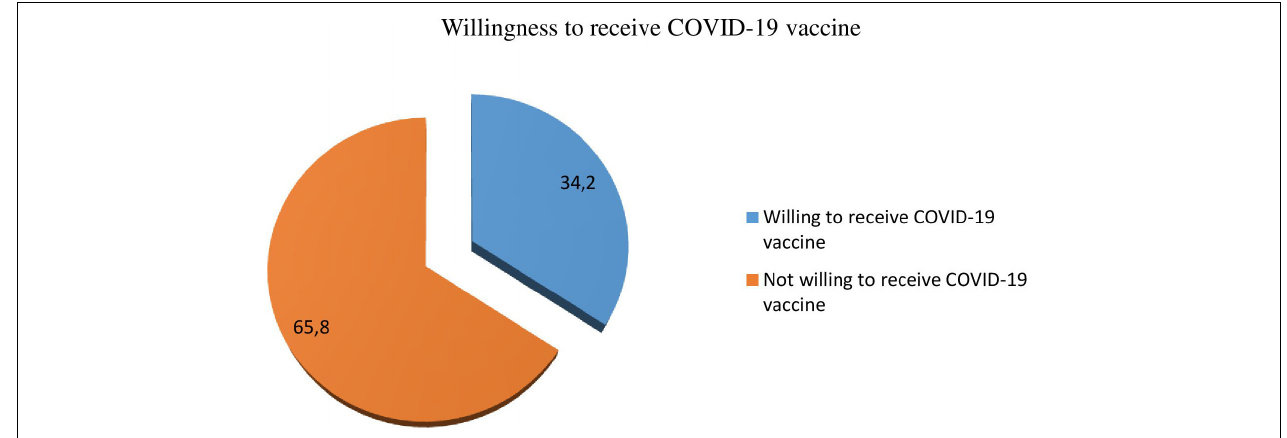
FIGURE 2 | COVID-19 vaccine acceptance among college students in Gondar town, Northwest Ethiopia, 2021 ( n =